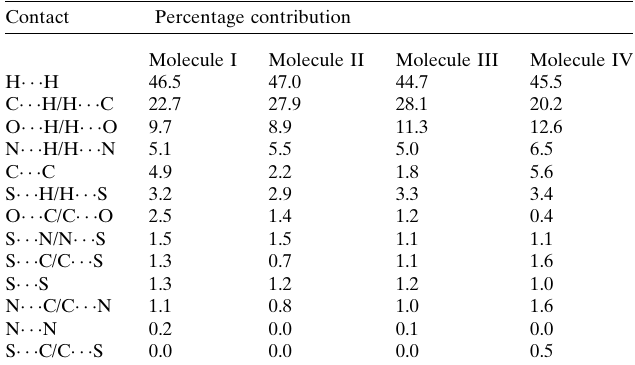
Table 5 Percentage contributions of interatomic contacts to the Hirshfeld surface for the title compound.